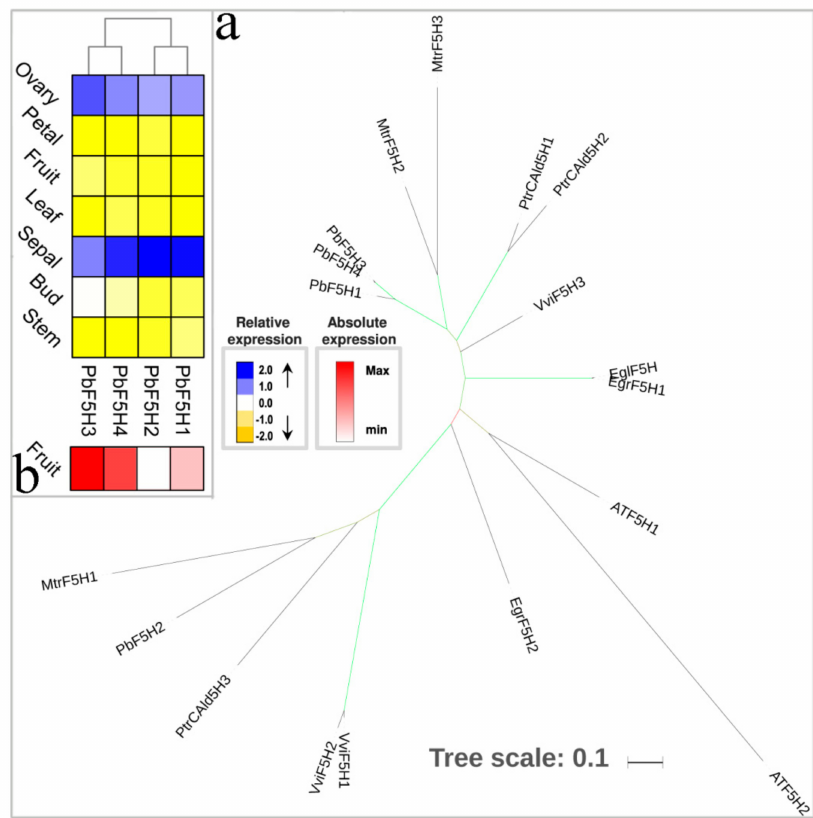
Figure 4. Phylogenetic tree and expression profiles of the F5H bona fide clade. ( a ) ML tree built with F5H bona fide enzymes from several species. ( b ) The expression profiles P. bretschneideri F5H bona fide genes. The green color of the tree branches suggests strong node support (bootstrap support ≥ 95% and SH-aLRT ≥ 75%). The FPKM values of PbF5H genes in di ff erent tissues are indicated in Table S3. The gene accession number is indicated in Table S4. The tree scale is the number of amino acid substitution per